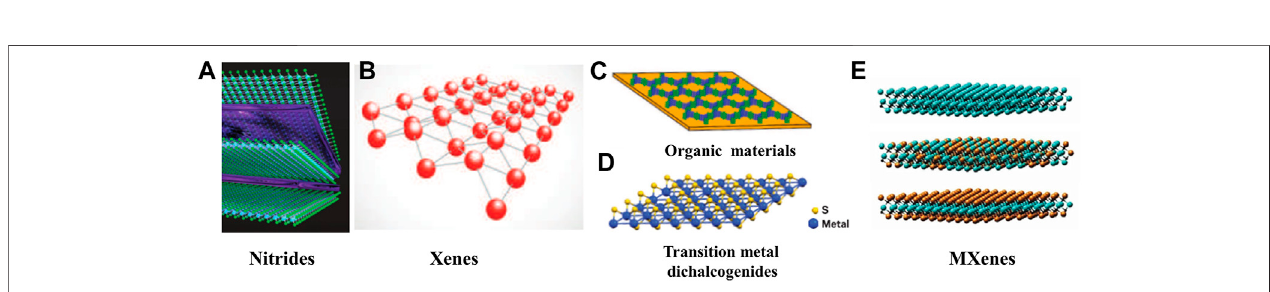
FIGURE 3 | Classi fi cation of two-dimensional materials. (A) Nitrides. (B) Xenes. (C) Orangic materials. (D) Transition metal dichalcogenides (reproduced from (Jacoby, 2017) with permission from Royal Society of Chemistry). (E) MXenes (reproduced from (Huang et al., 2018) with permission from Royal Society of Chemistry).